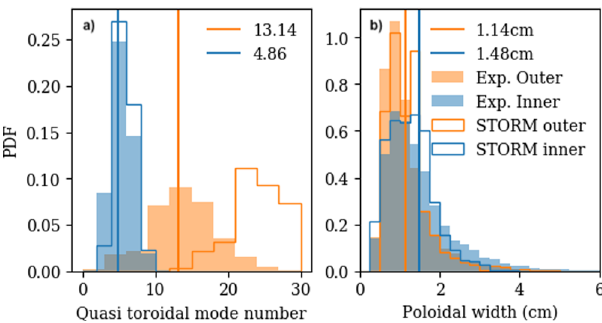
Fig. 2 Spatial distribution and width of turbulent structures in the divertor. a Quasi-toroidal mode number and ( b ) poloidal Full-Width Half- Maximum cumulative distributions of turbulent structures across all discharges detailed in table 1. Mean values are represented by vertical lines. Data from the simulation 36 is shown as solid lines, whilst experimental data as fi lled histograms. The clear separation in the histograms of toroidal mode number between inner and outer legs demonstrate strong evidence that turbulence in the two legs is